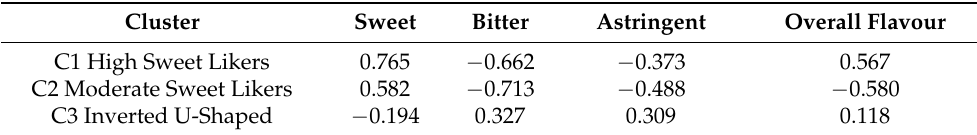
Figure 2. Mean liking ratings for each of the three clusters as a function of sucrose concentration under the four test conditions (CHOC1: sucrose concentration 38 g/kg, CHOC2: 83 g/Kg, CHOC3: 119 g/Kg, CHOC4: 223 g/Kg). a,b,c,d Different letters indicate a significant difference in the Bonferroni post hoc test (0.05). When the letter is the same for all clusters for the same sample only one letter is reported. Table 1. Class centroid for each cluster.